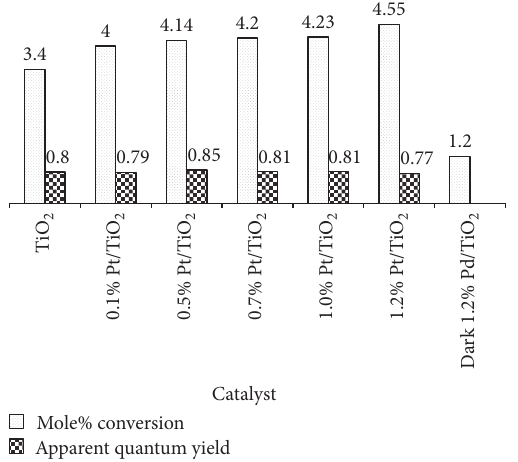
Figure 3: Effect of Pt loading on titania used for solvent-free photo/dark oxidation of toluene. Reaction conditions : toluene: 20 mL, cat: 100mg, temp: 333 K, irradiance: 3hrs, flow: 40 mL/min, pO 2 : 760 torr, and stirring: 850 rpm.